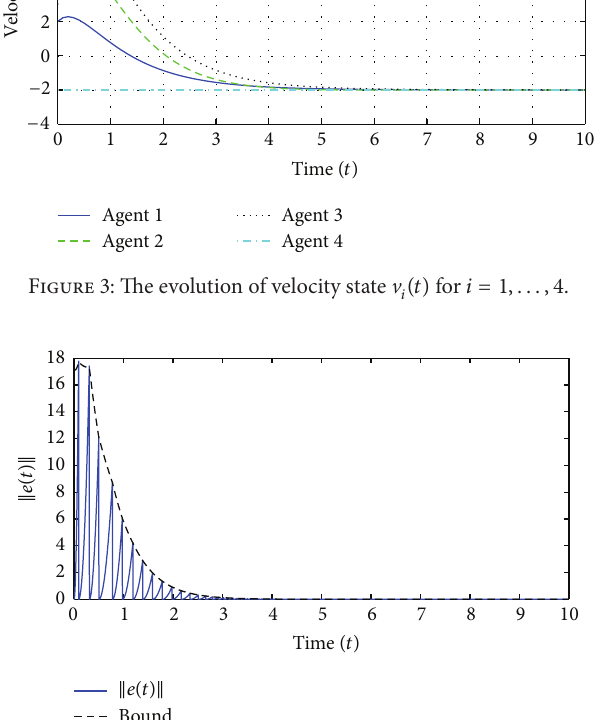
The initial conditions of system (9) are 𝑥(0) = col (2, −4, −9, 9) , V (0) = col (2, 6, 3, −2) and 𝜏(0) = 0 . In the